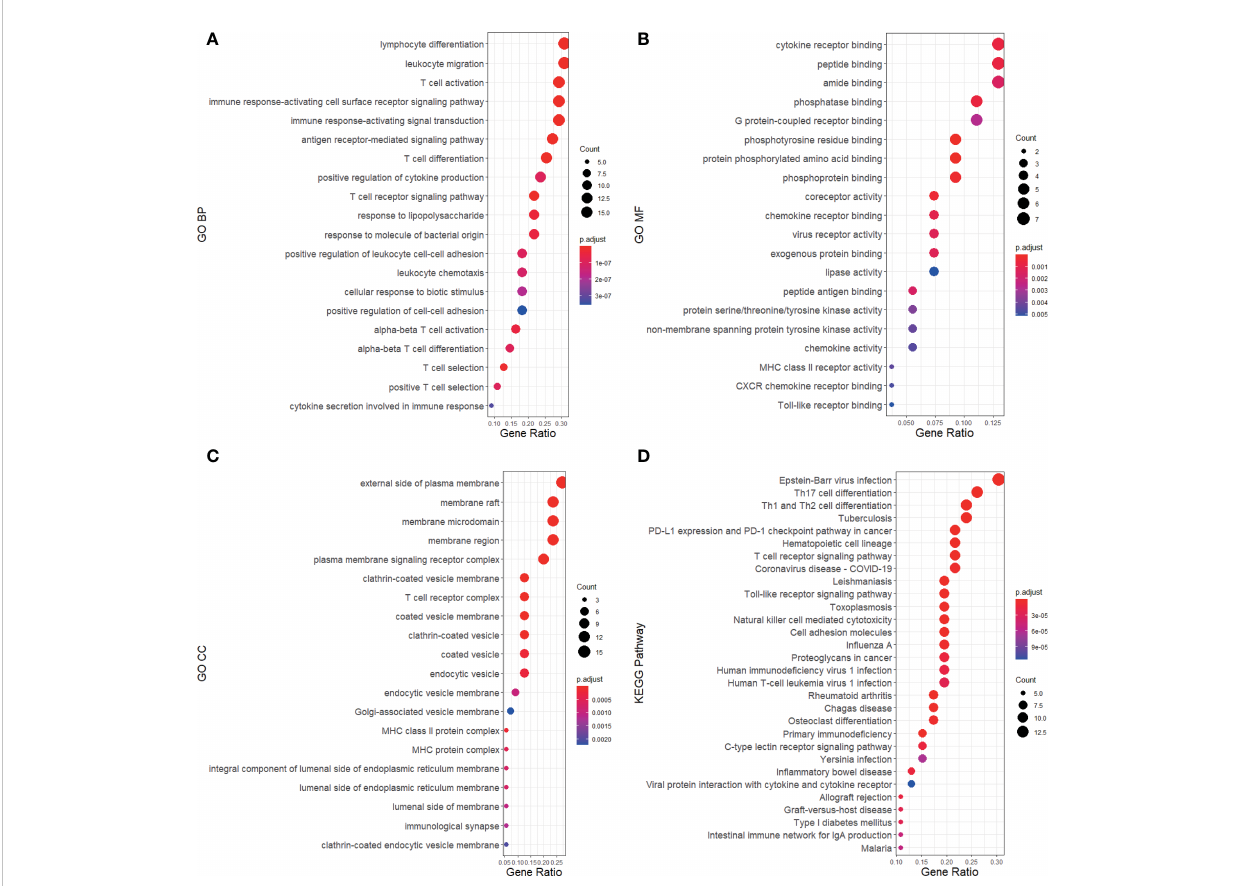
FIGURE 5 GO and KEGG pathway annotation for RA and MDD 55 core genes merged from 48 DEGs and 26 key genes of PPI network. The size of the ball represents the number of genes, and the color change of the ball corresponds to different p -values. (A) The fi rst 20 signi fi cantly enriched GO annotations of BP. (B) The fi rst 20 signi fi cantly enriched GO annotations of MF. (C) The fi rst 20 signi fi cantly enriched GO annotations of CC. (D) The fi rst 30 signi fi cantly enriched KEGG